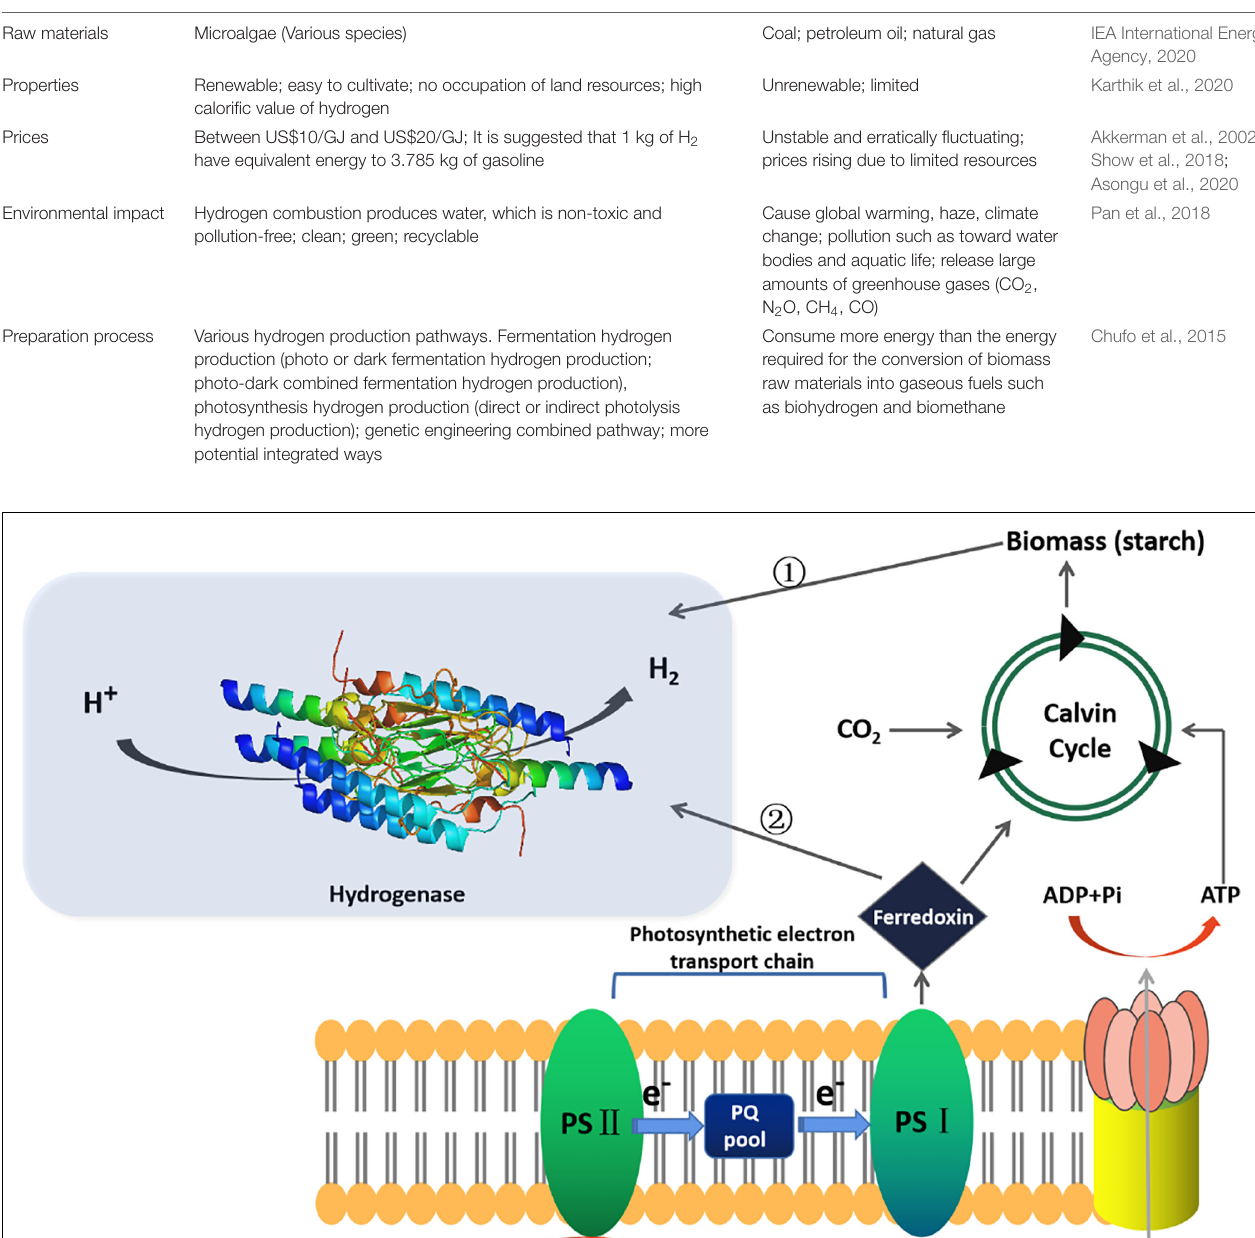
Frontiers in Energy Research |